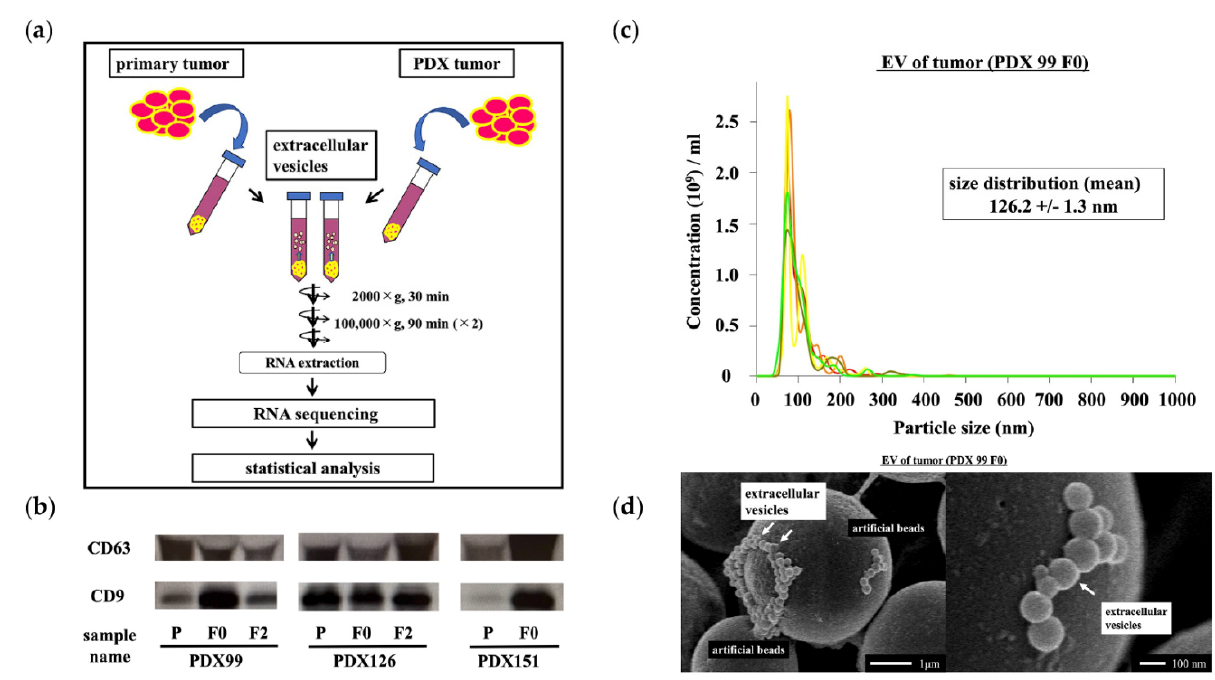
Figure 2. Isolation, characterization, and confirmation of extracellular vesicles (EVs). ( a ) EVs were isolated from the culture media of primary and patient-derived xenograft (PDX) tumors. Total RNA was extracted from the isolated EVs, and RNA sequencing was performed. The experimental results were statistically analyzed. ( b ) Western blot analyses were performed to detect exosomal marker proteins (CD9 and CD63) in vesicles released by primary and PDX tumors. Representative examples of bands from three independent experiments are shown. ( c ) The particle size distributions and concentrations of EVs were measured using NanoSight NS 300. ( d ) Representative images of EVs obtained using scanning electron microscopy.